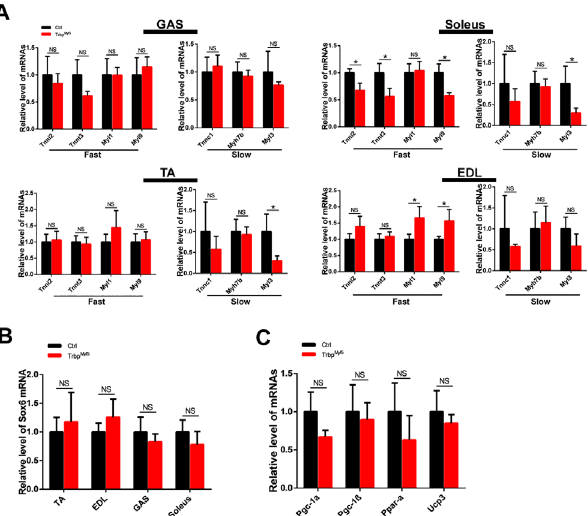
Fig 4. Fast- and slow- twitch myofiber gene expression in skeletal muscle-specific Trbp mutant mice. (A) qRT-PCR analysis of fast- and slow- twitch myofiber genes in GAS, Soleus, TA and EDL muscle tissues of 4-week old control and mutant mice (n = 3); (B) qRT-PCR of Sox6 mRNA levels in TA, EDL, GAS and Soleus muscle tissues of 4-week old control and mutant mice (n = 3); (C) qRT-PCR analysis of metabolic markers in skeletal muscle of 4-week old control and mutant mice (n = 3). Data are presented as Mean ± SEM. Ctrl, control; Trbp Myf5 , Trbp f/f ::Myf5-Cre. EDL, extensor digitorum longus; GAS, gastrocnemius; TA, tibias anterior. NS, not significant. * , P <